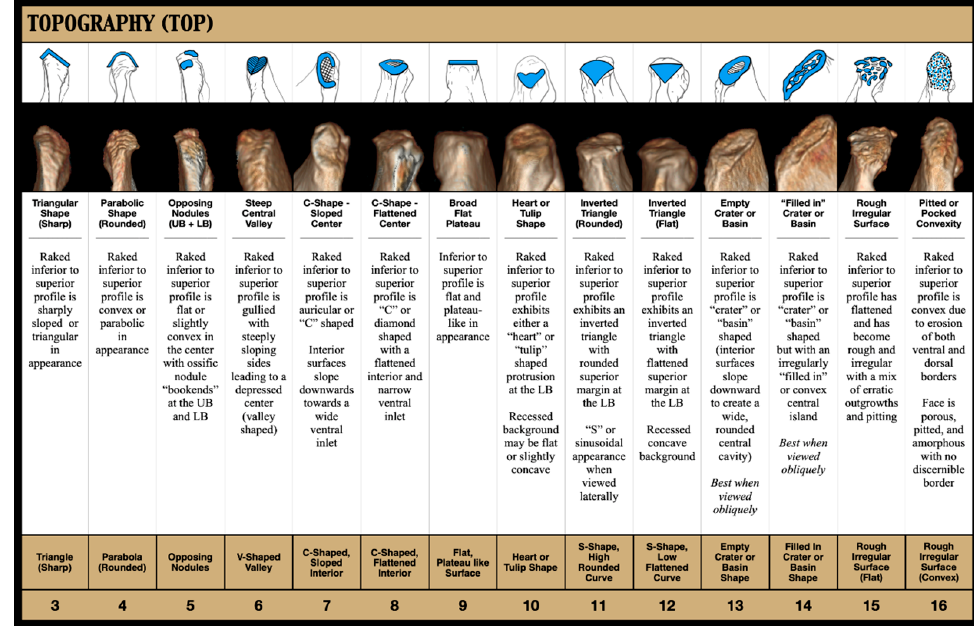
Figure 11. Guide to Topography.